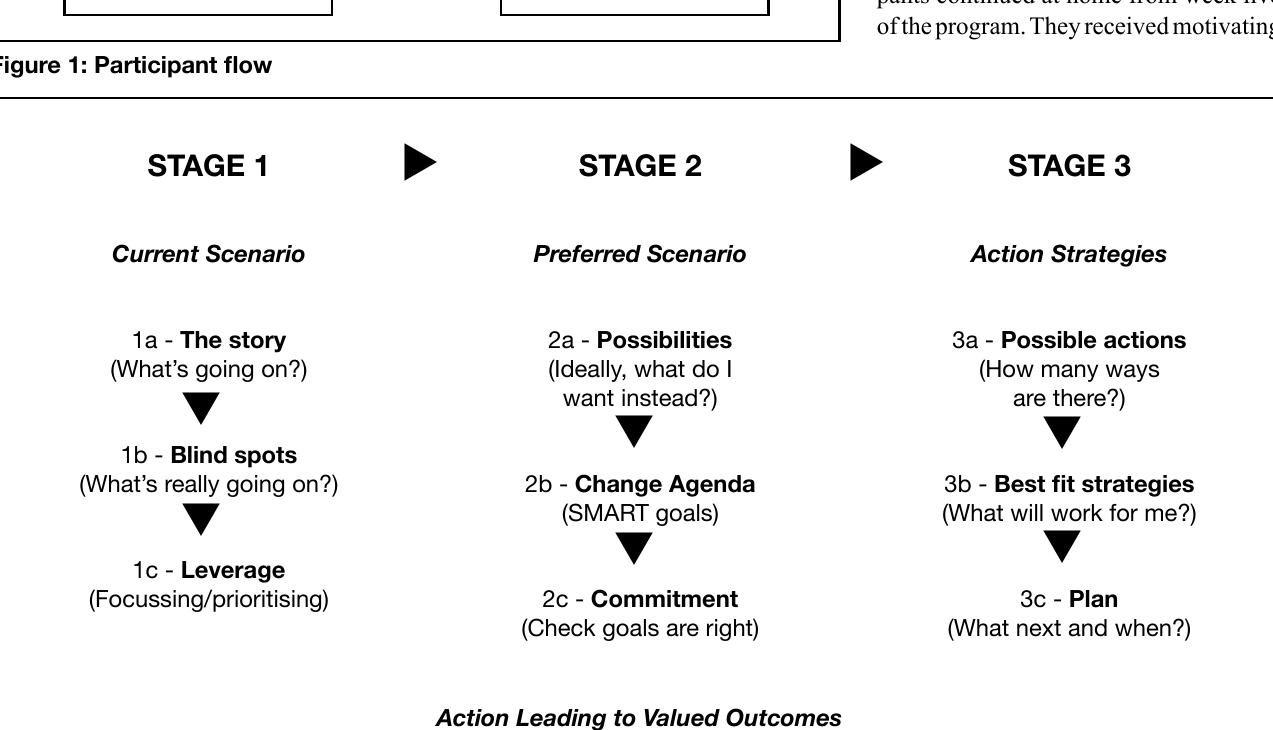
figure 1: Participant flow